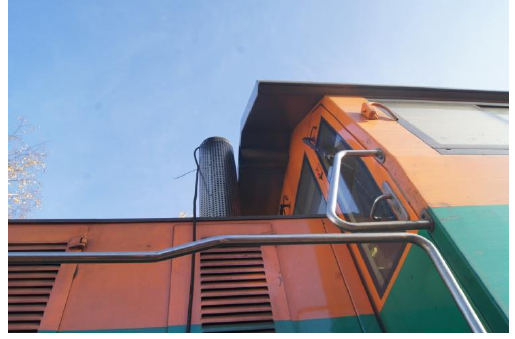
Fig. 4. General view of the exhaust gas sampling from the locomotive